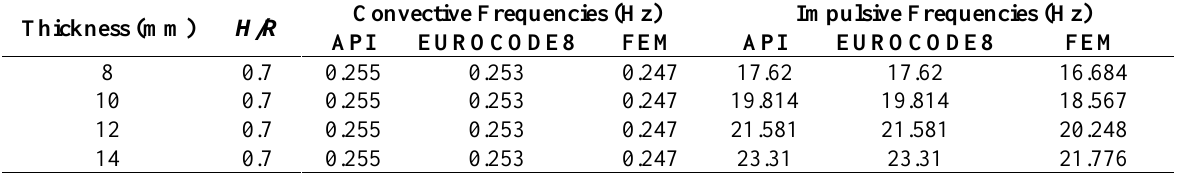
Fig. 6. Comparison of the effect of viscosity on frequencies (Hz), a) convective, b) impulsive Table 11. Comparing of impulsive and convective